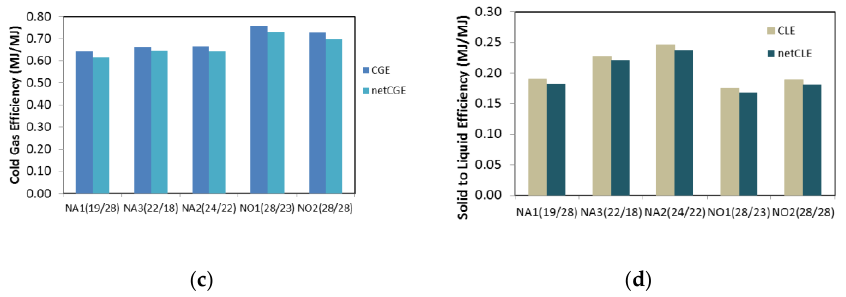
Figure 12. Gasification of hazelnut shells (N): ( a ) 3D plot of efficiency of energy conversion in the gasification as function of the equivalence ratio ER(O 2 ) and ER(H 2 O); ( b ) 3D plot of thermal power of the plant as function of the equivalence ratio ER(O 2 ) and ER(H 2 O); ( c ) Cold Gas Efficiency (CGE) and the corresponding net values; ( d ) Cold Liquid Efficiency (CLE) and the corresponding net values.